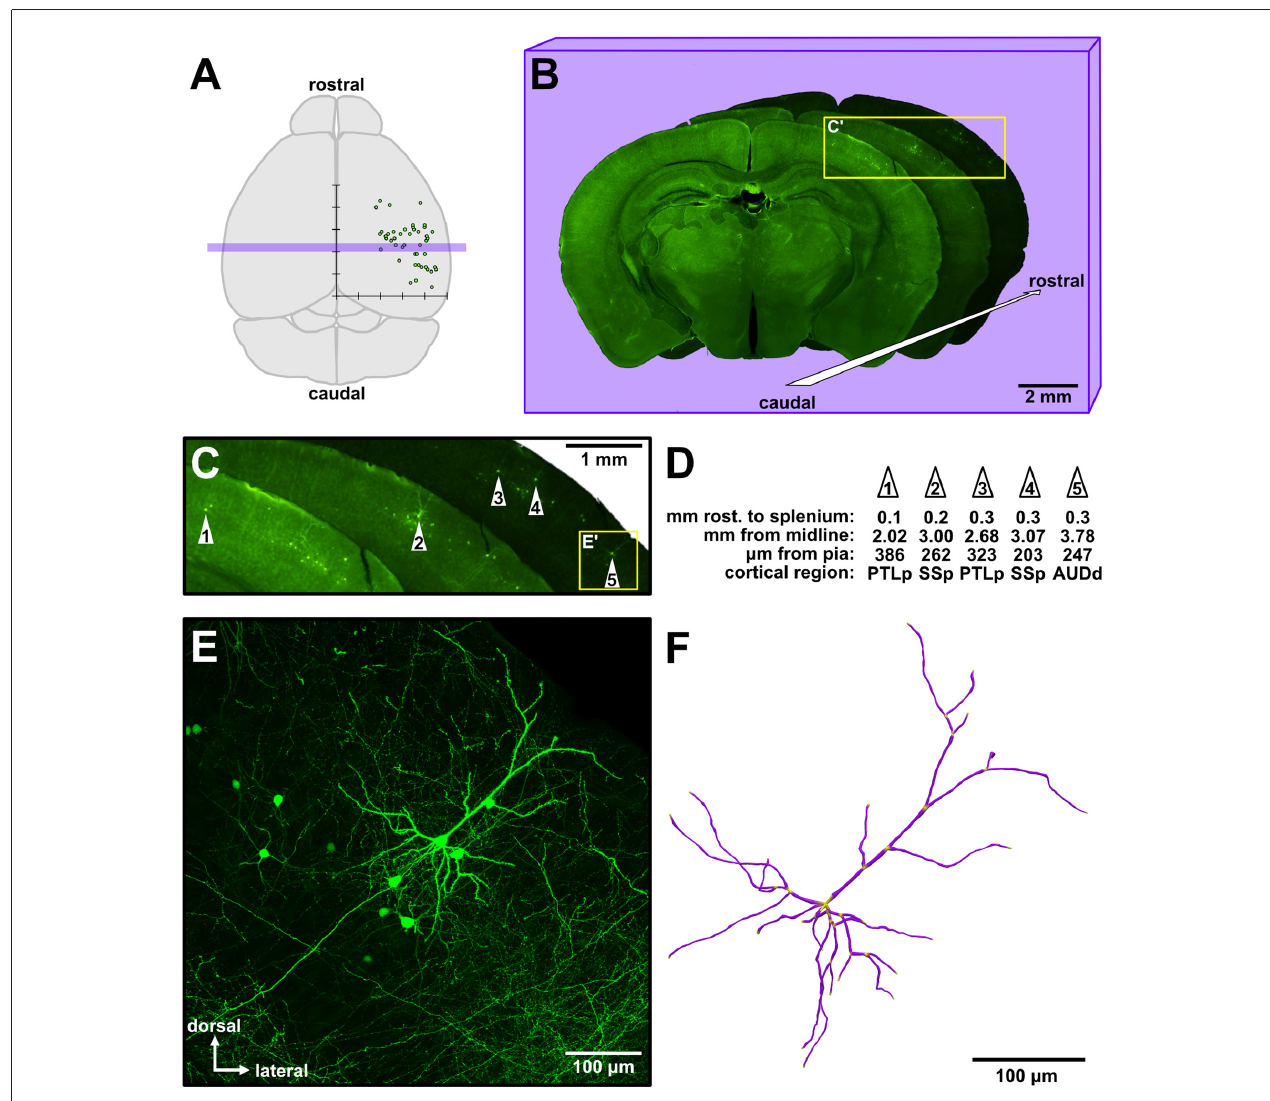
FIGURE 1 | Sparse targeting of isochronically-sourced supragranular pyramidal neurons throughout the cerebral cortex permits morphological interrogation over a broad cortical area. (A) Schematic of the mouse brain (dorsal view). Overlaid is a graph depicting the approximate location of analyzed neurons from an experimental brain (see Figure 4A for detailed presentation of these data). The x -axis indicates the neurons’ distance to the midline, the y-axis indicates the relative rostrocaudal position of the neurons, and tick marks are spaced 1 mm apart. Purple rectangular overlay indicates the three coronal sections shown in (B) . (B) Example of three low-magnification images of consecutive coronal sections from an experiment, in a cascading arrangement from caudal (foreground) to rostral (background). The overall brightness of each section was altered to allow better visual distinction among the three sections. (C) Magnified view of the inset in (B) , showing the general area of green fluorescent protein (GFP) labeling in these sections. The five neurons analyzed from these sections are identified by white numbered arrowheads. (D) Example measurements taken from the five neurons identified in (C) . The first row indicates the distance of each neuron rostral to the splenium of the corpus callosum along the rostrocaudal axis. PTLp, posterior parietal association area; SSp, primary somatosensory area; AUDd, dorsal auditory area. (E) Medium-magnification (20 × ) maximum intensity Z-projection of confocal images (see Supplementary Figure S1 ) taken of cell #5 (inset in C ). (F) A complete reconstruction of all apical and basal dendrites of the neuron in (E) , rendered in